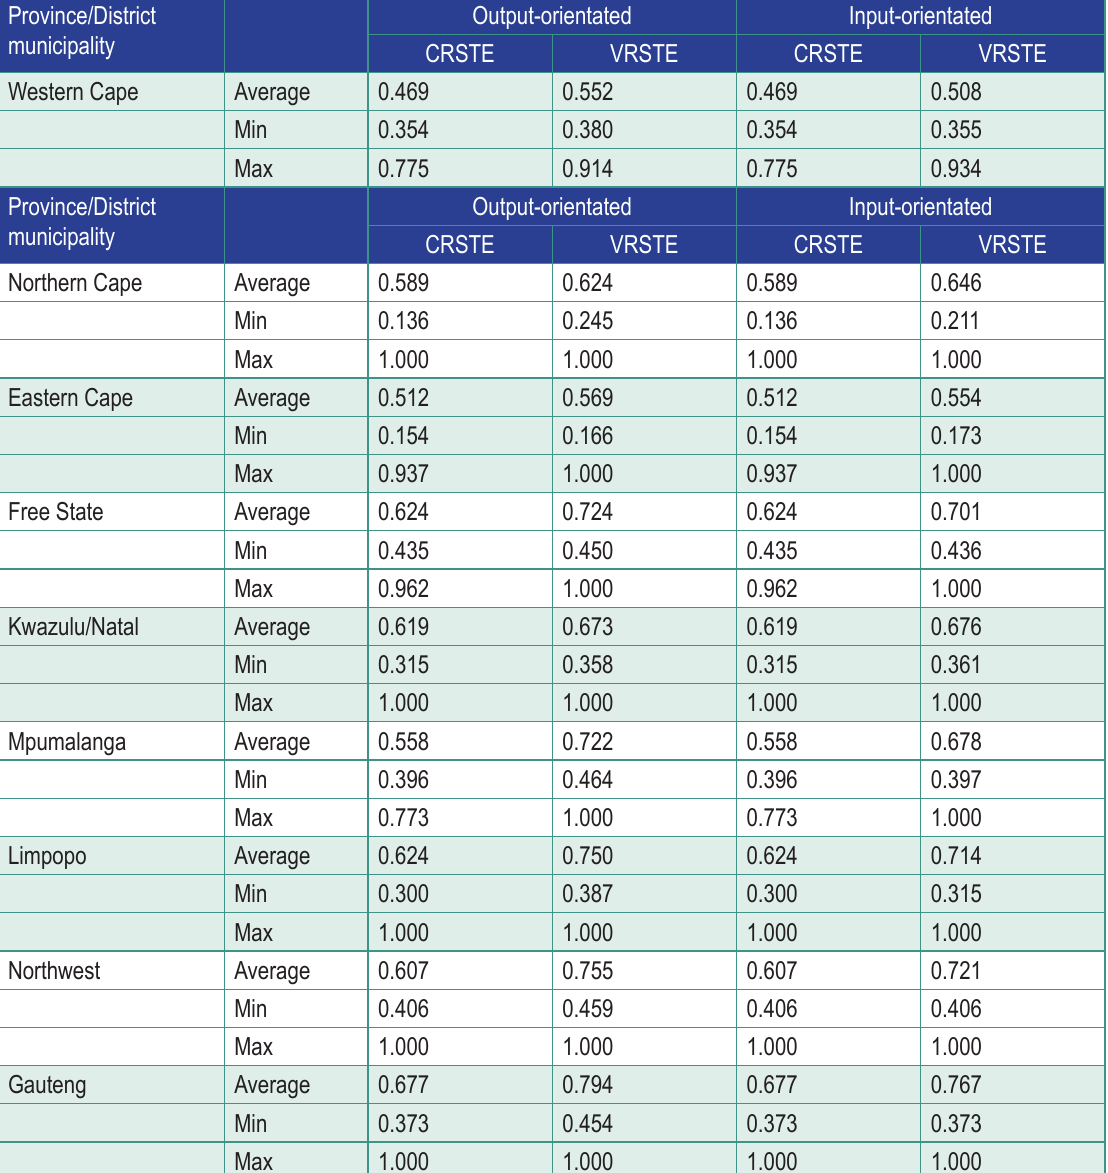
Table 4: Average Efficiency Estimates of Local Municipalities per